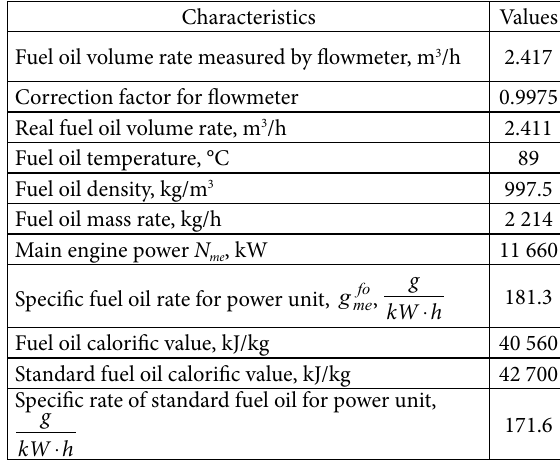
Table 5. Fuel oil consumption based on trial data